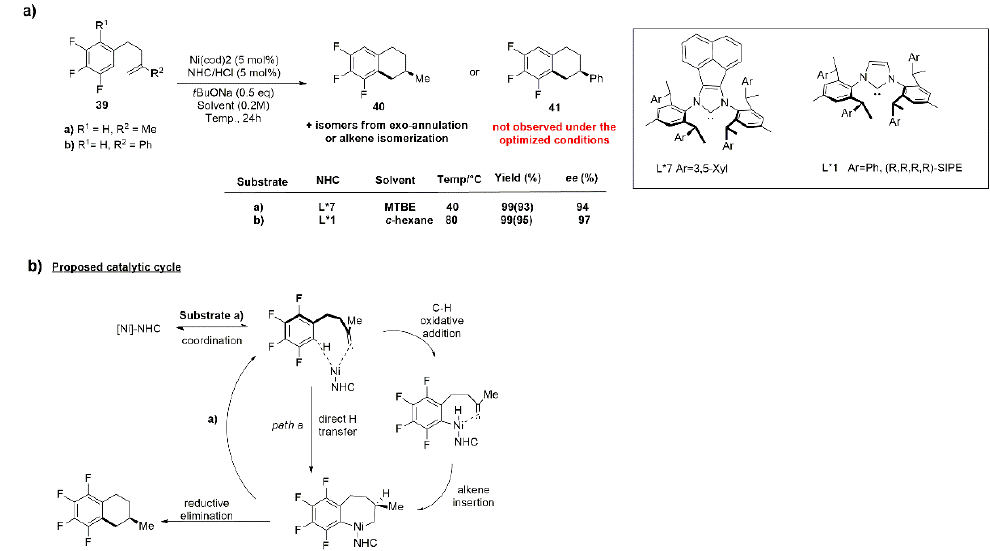
Figure 22. ( a ) Catalytic enantioselective C-H functionalization of polyfluoroarenes ( 39 ); ( b ) pro- posed catalytic cycle.